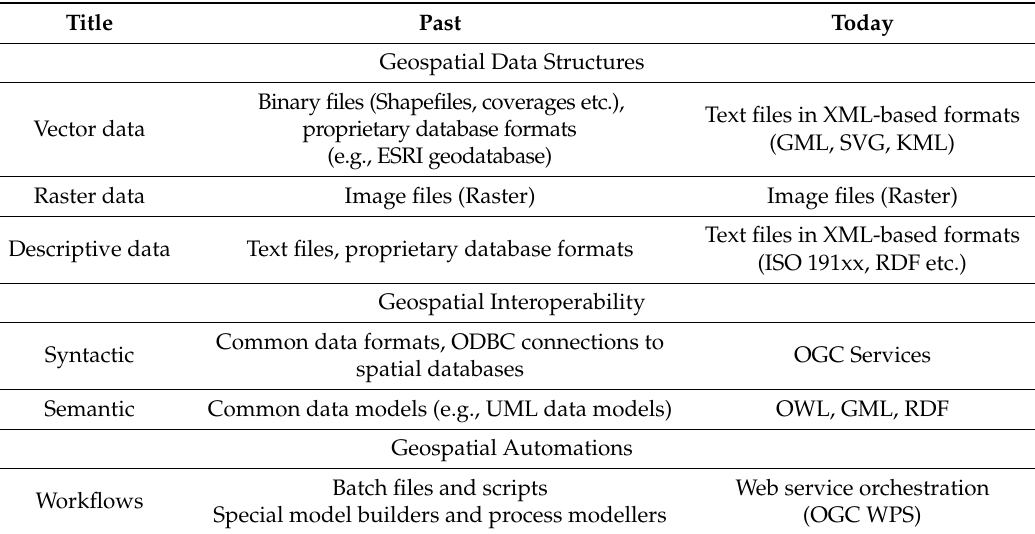
Table 1. Impact of Web semantics on geospatial